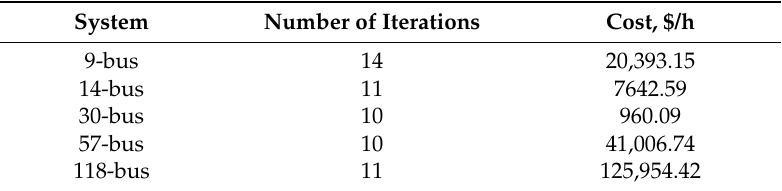
Table 2. Application of the interior-point algorithm to different test power systems.